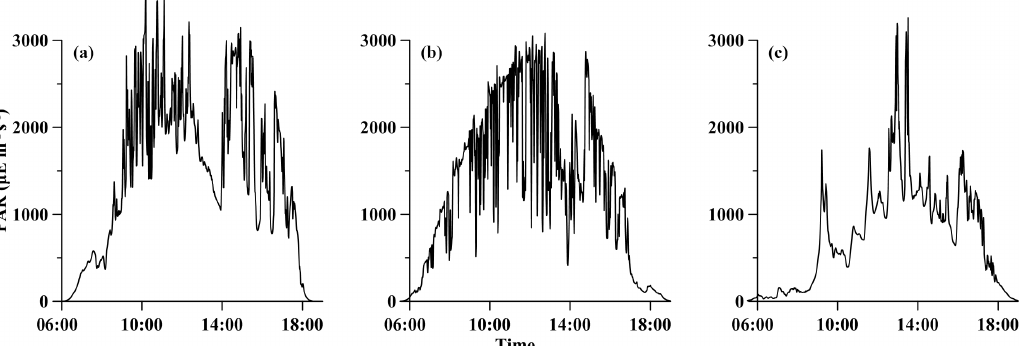
Figure 1. Temporal variations in photosynthetically active radiation (PAR µEm − 2 s − 1 ) obtained on deck during the experiment periods, (a) for station S0320, (b) for station A3 and (c) for station